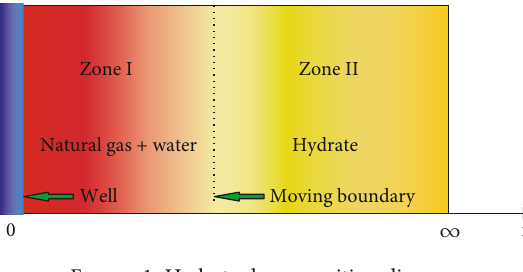
Figure 1: Hydrate decomposition